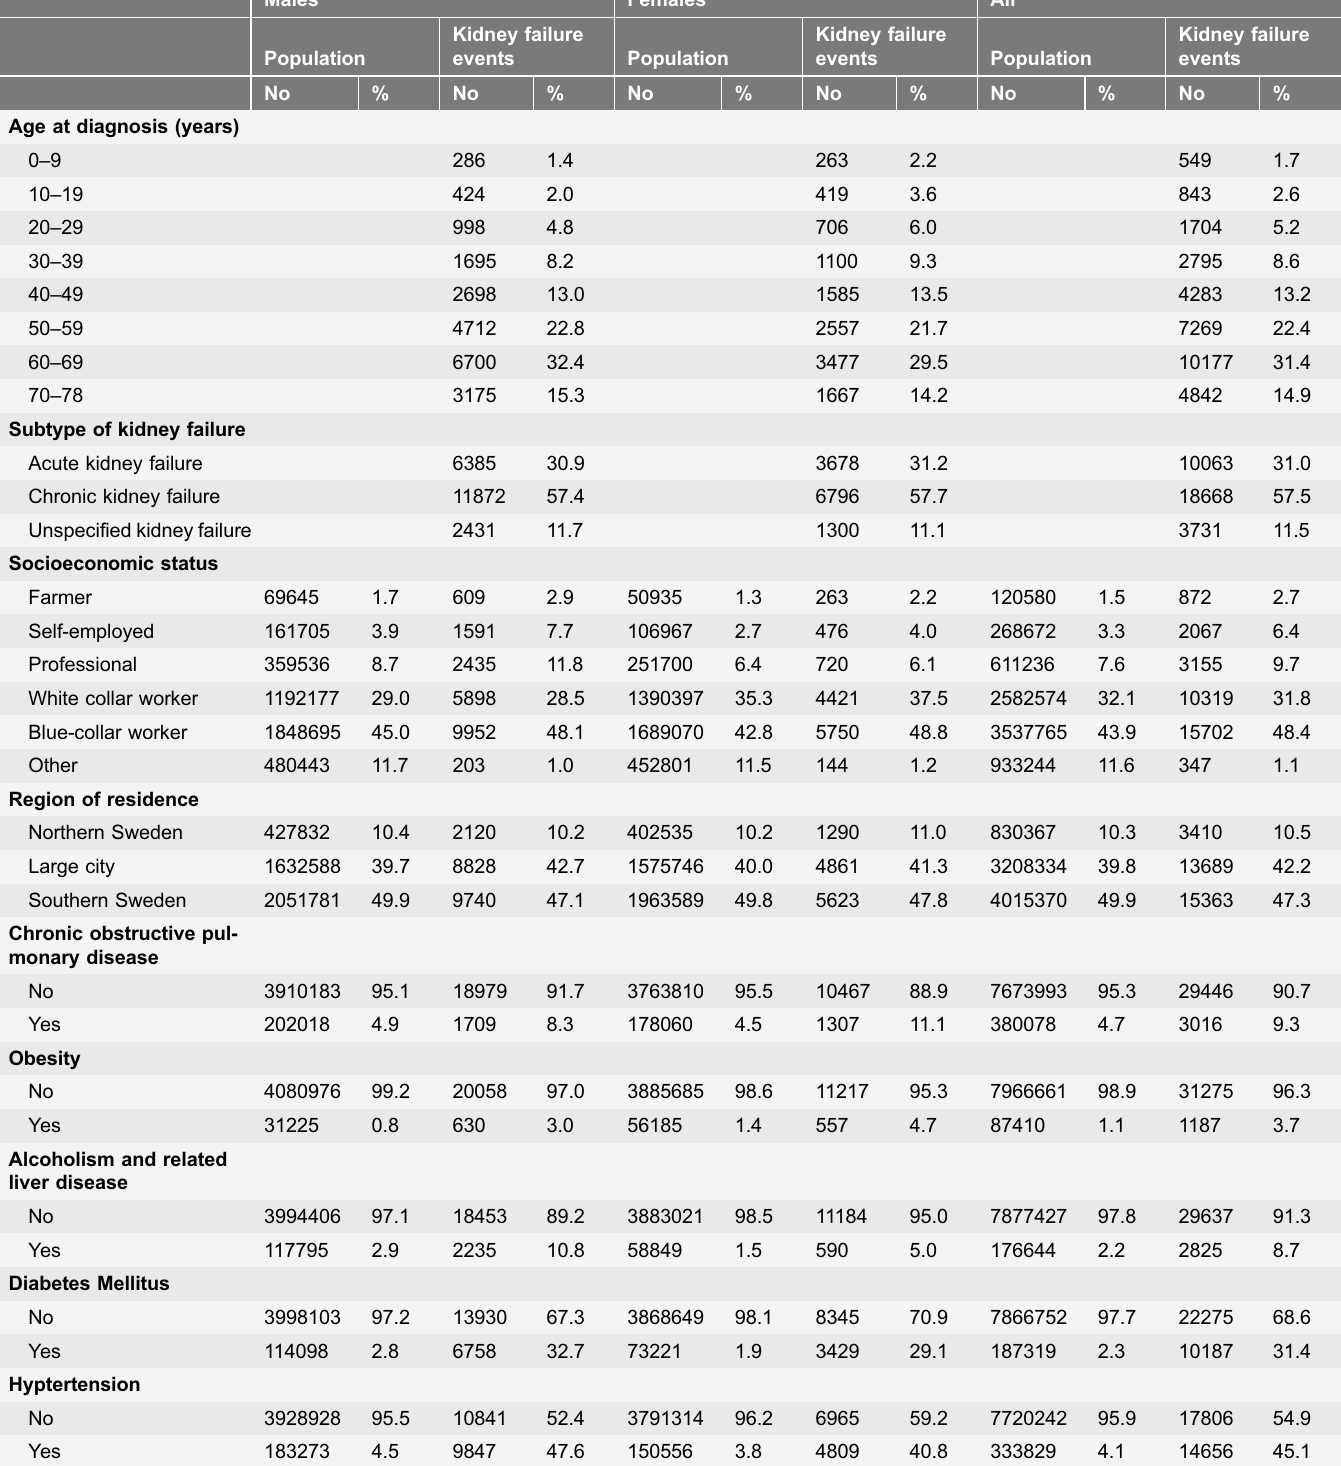
Table 1. Study population and number of kidney failure events in individuals aged 0 to 78 years (born 1932 and later and alive in